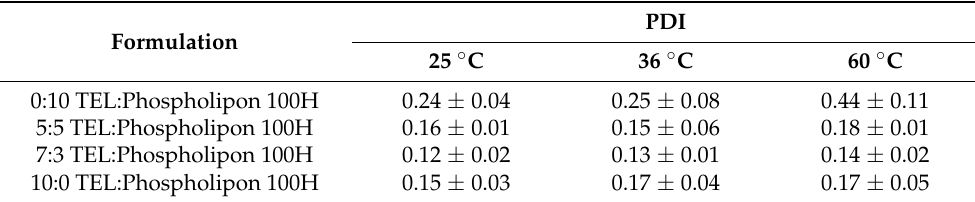
Table 2. The polydispersity index (PDI) of liposomes composed of tetraether lipids (TEL) and Phospholipon 100H (Ph) in different molar ratios (0:10, 5:5, 7:3, 10:0; TEL:Ph) incubated for 4 h at 25, 36, and 60 ◦ C.